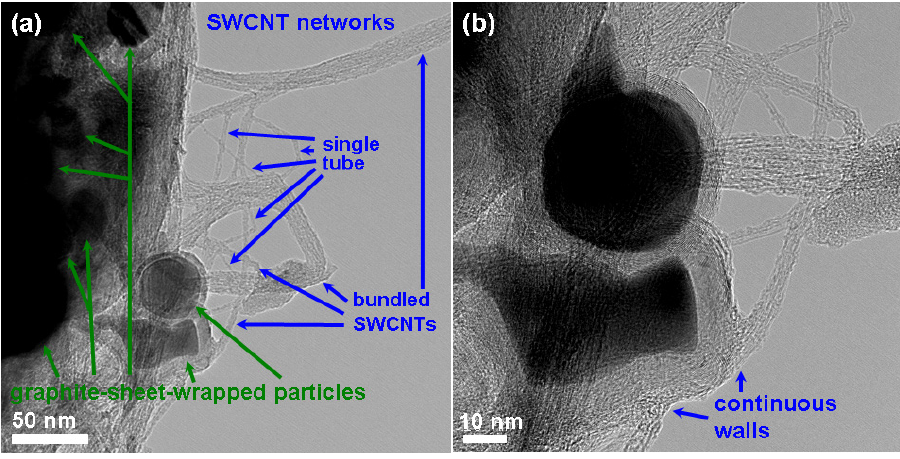
Figure 3. TEM images of the SWCNTs grown from catalyst particles and/or branched from growing